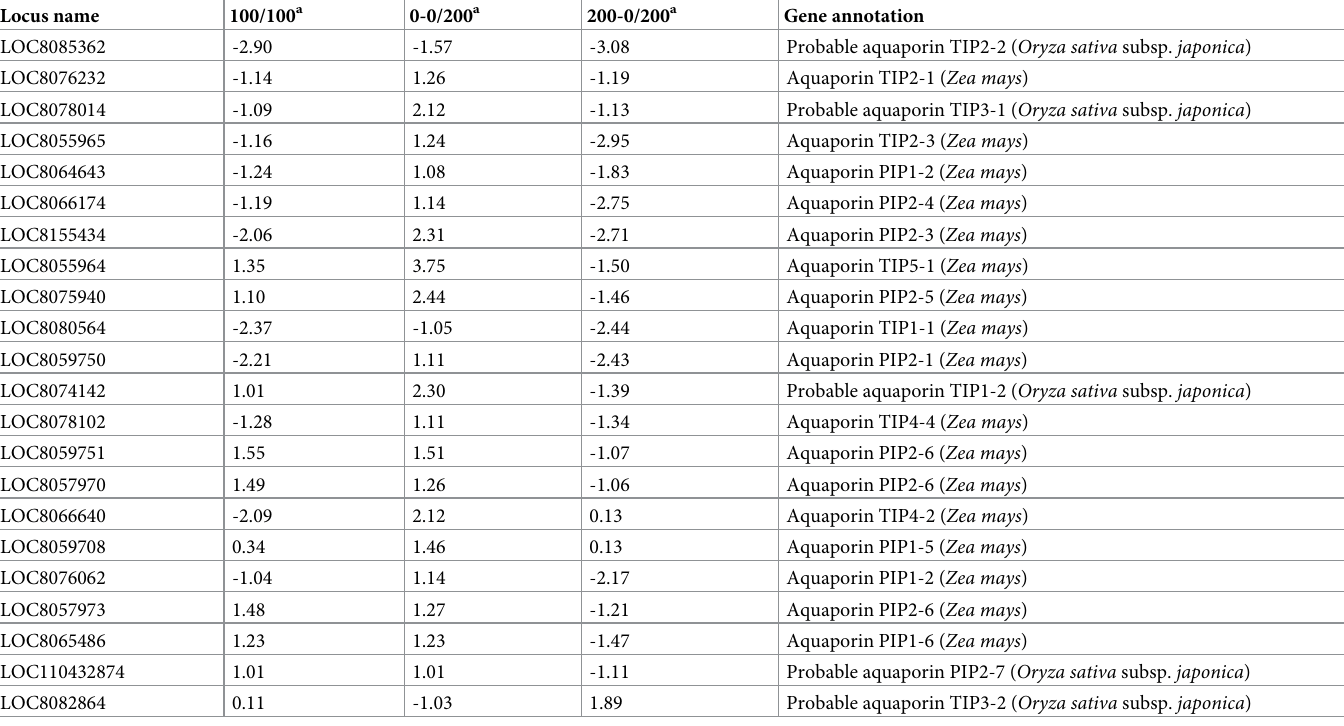
Table 3. Summary of differentially expressed aquaporins in roots under uniform and non-uniform salinity treatments.